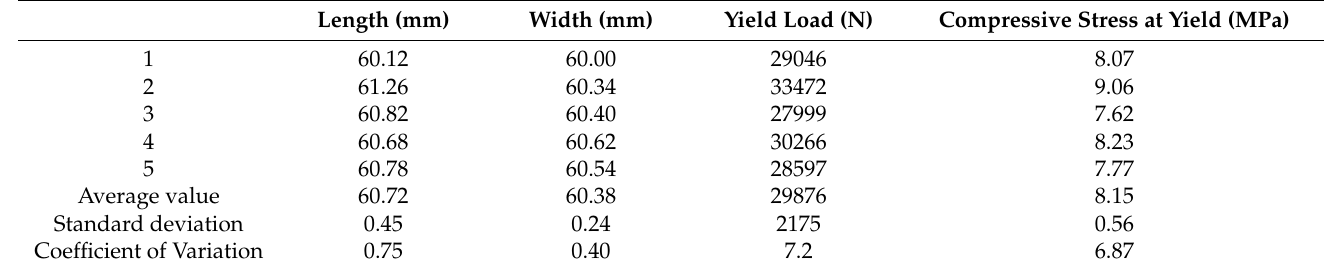
Table 6. Data of sample group